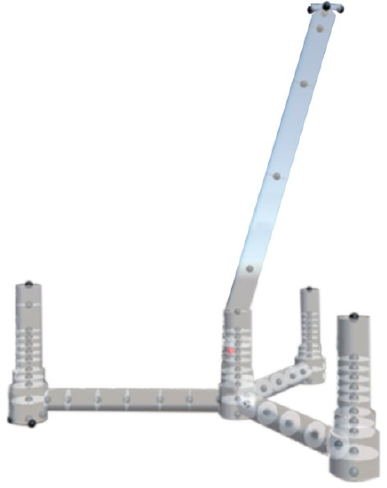
Figure 7. Mesh and nodes considered in the NK-UTWind code analysis.